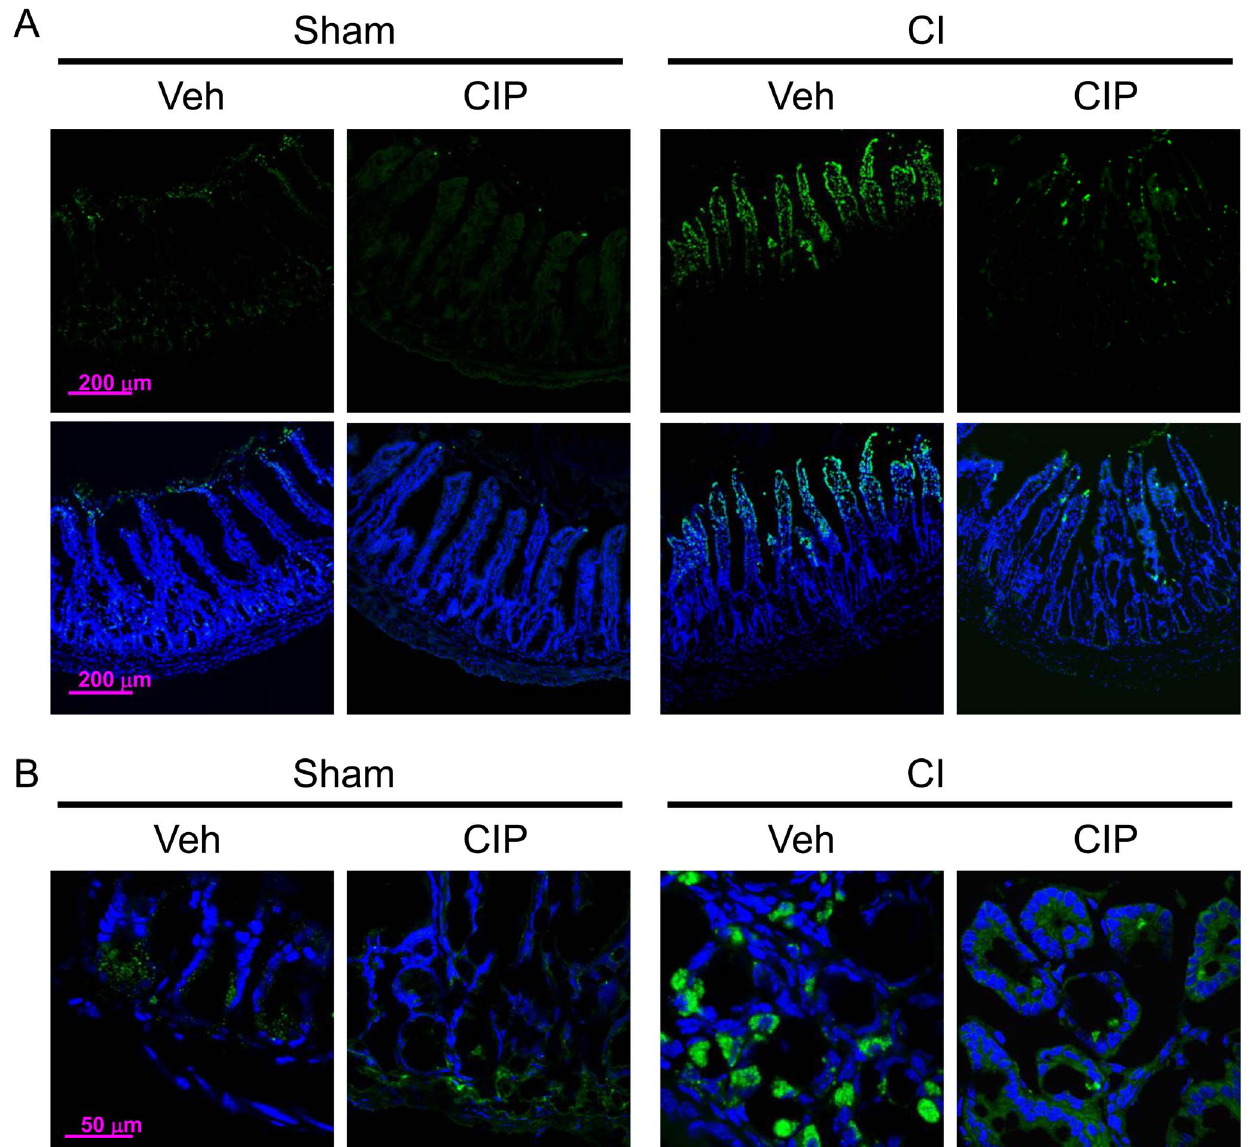
Figure 6. CIP inhibited apoptosis and autophagy in ileum after CI. On day 10 after CI, ileal samples were collected from surviving mice and prepared for immunofluorescent staining on frozen sections. (A) TUNEL assay was performed to identify apoptotic population (green) and presented with (bottom) or without (top) nucleus (blue), and (B) LC3 was stained to identify autophagic population and presented with nucleus (blue). Representative pictures are shown. n=4 2 5 per group. CI: combined injury; CIP: ciprofloxacin; Veh: vehicle.